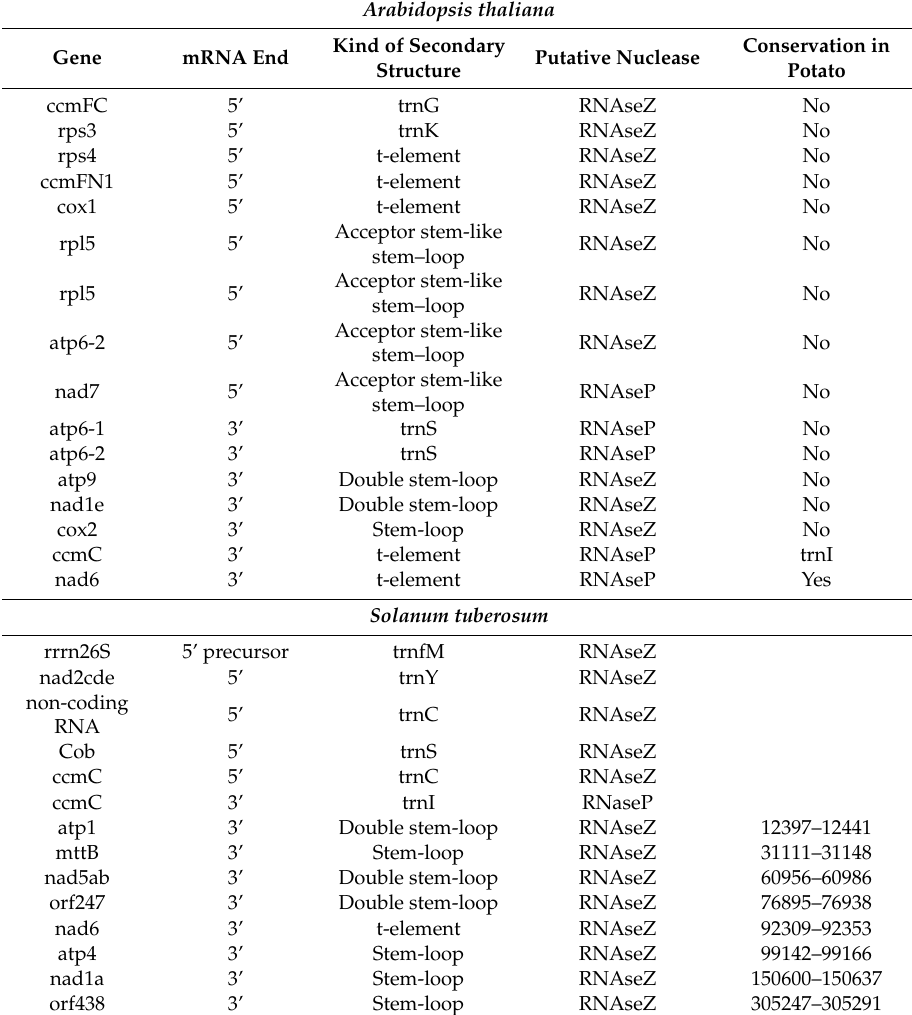
Table 3. List of stem-loops and